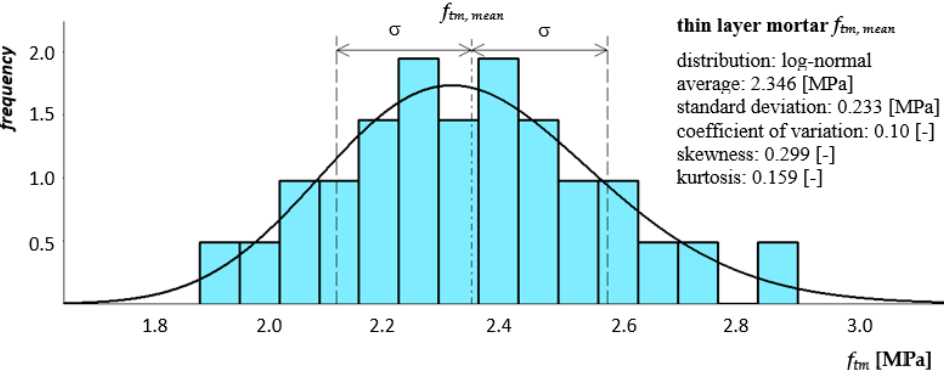
Figure 12. Histogram together with the approximate function of the tensile strength distribution when bending thin-layer